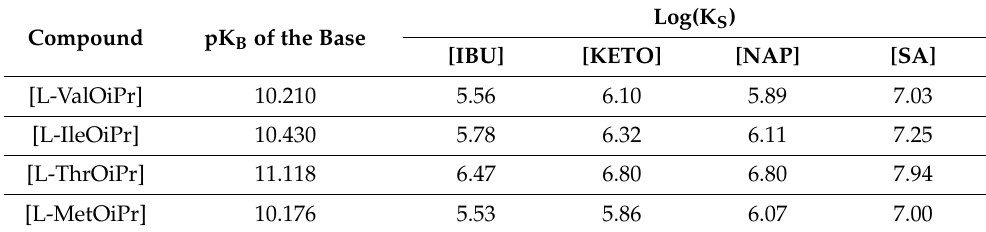
Table 5. The formation constants log(K S ) of L-amino acid isopropyl ester salts.